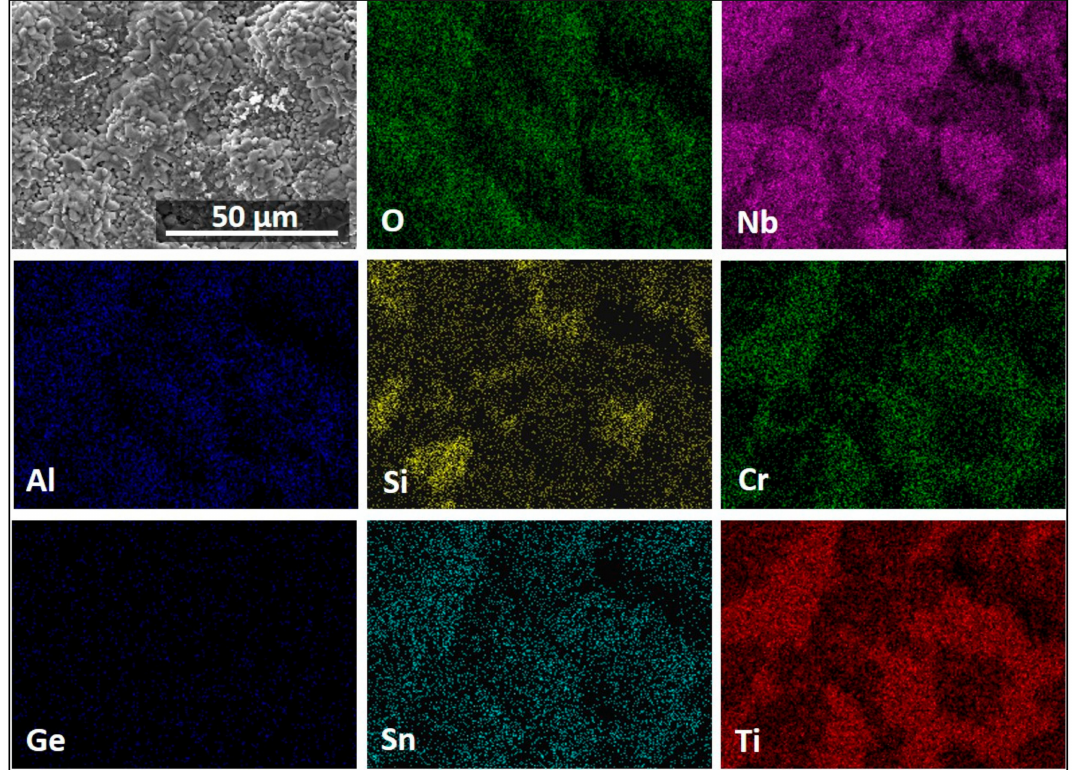
Figure 11. SE image and X-ray elemental maps of the scale surface of the alloy OHS1 after isothermal oxidation in air at 1200 ◦